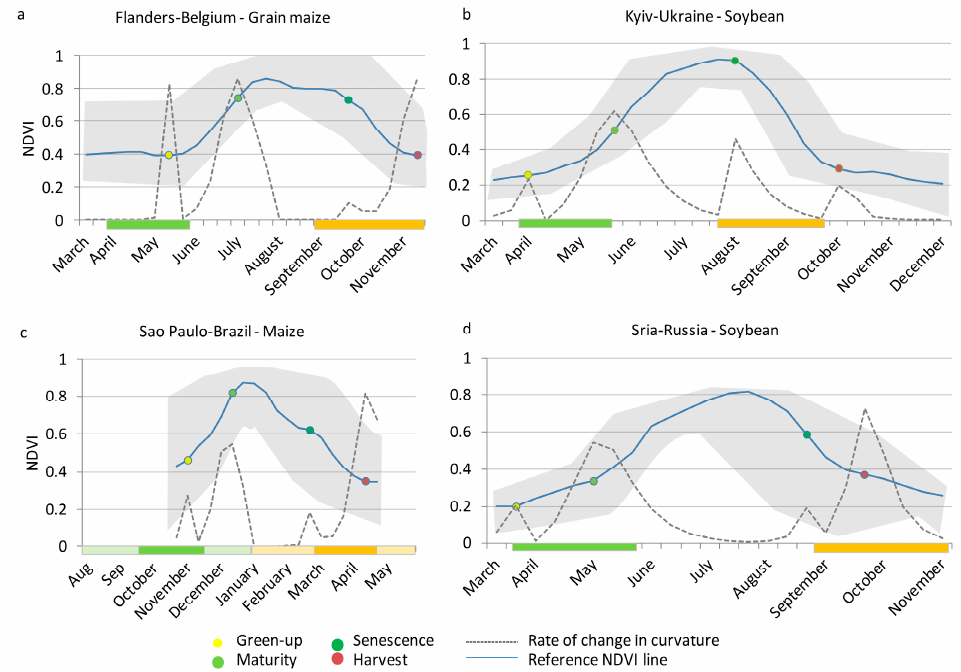
Figure 4. ( a – d ) Crop time windows for maize in Flanders-Belgium ( a ) and Sao Paulo, Brazil ( c ); and for soybean in Kyiv, Ukraine ( b ), and Sria, Russia ( d ). The four phenological transition dates were calculated from piecewise logistic functions. The grey zone represents the minimum and maximum NDVI values in the training dataset. The crop calendar for each study site is presented below each graph, where green represents the planting time and orange the harvesting time. Light green and orange colors represent periods with low activity for maize in Brazil.